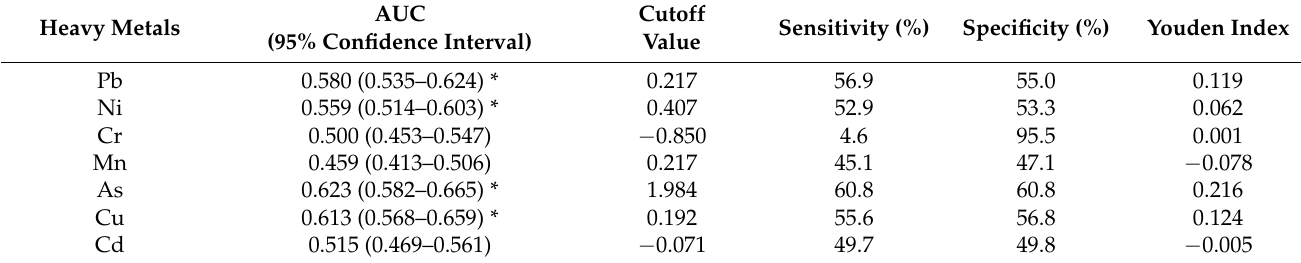
Table 6. Area under the curve (AUC), cutoff value, Youden index, and sensitivity and specificity of seven heavy metals for an eGFR of < 60 mL/min/1.73 m 2